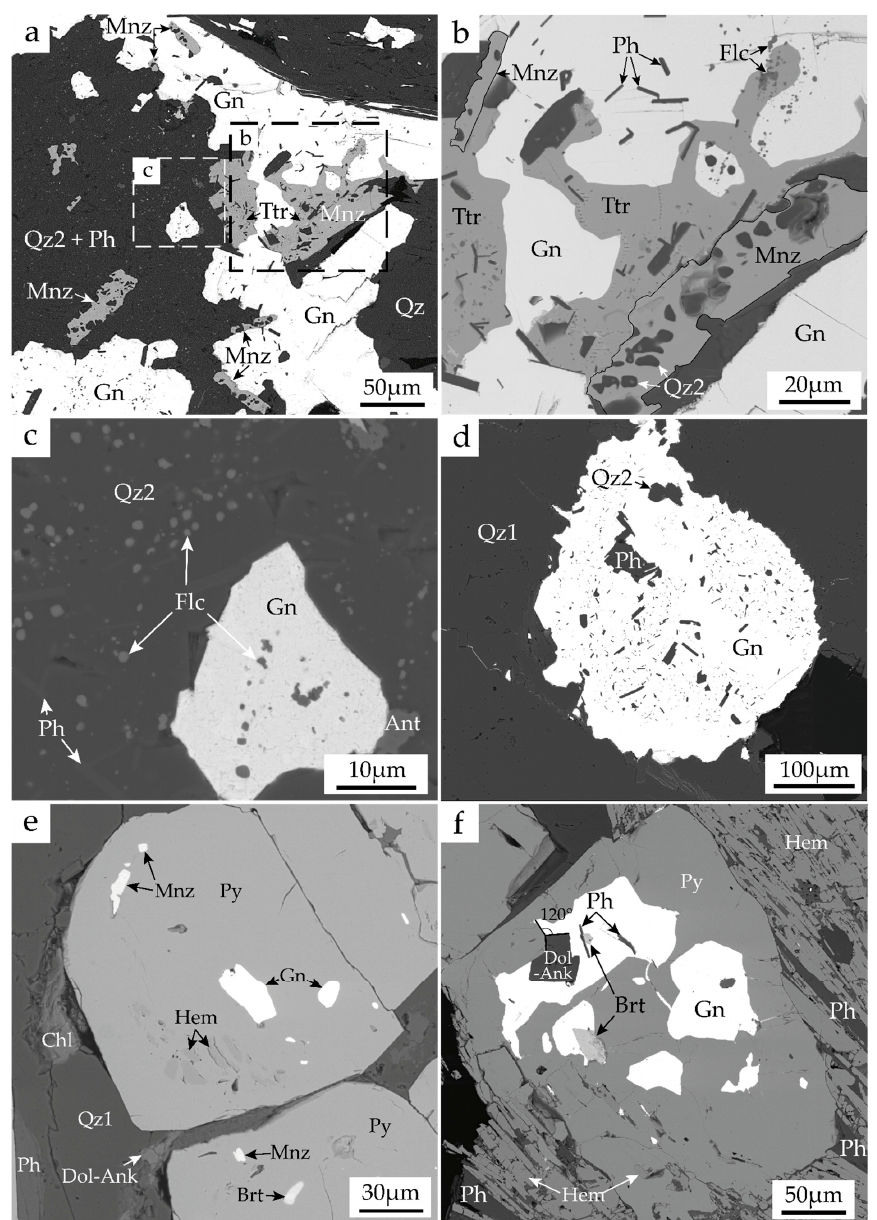
Figure 5. Backscattered electron (BSE) images of sulfides–sulfosalts from PN (PN16-05a; ( a – d )) and MB (3501-5b; ( e , f )) ores. ( a ) Galena and tetrahedrite hosted in quartz and phengite matrix (PN16-R05a), dashed squares show the location of ( b , c ) images. Note (i) monazite inclusions within galena and the intergrowth between galena, tetrahedrite, and monazite; (ii) the poikilitic texture of